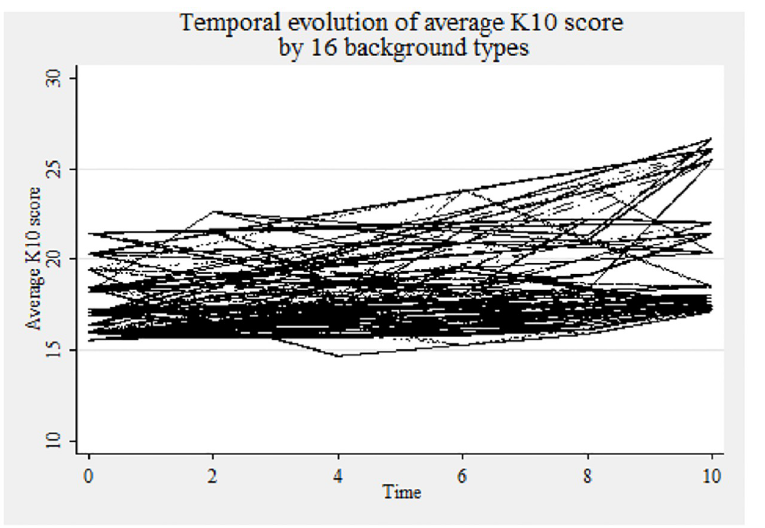
Fig 3. Temporal evolution of mental health status (K10 score) by